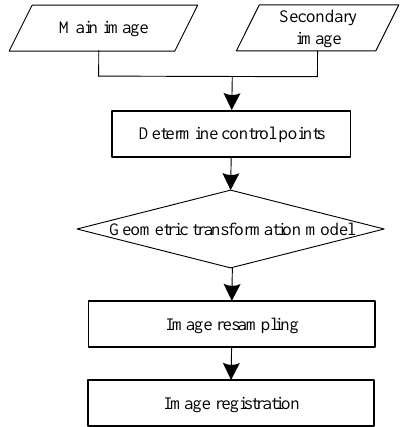
Figure 2. The image registration flow diagram